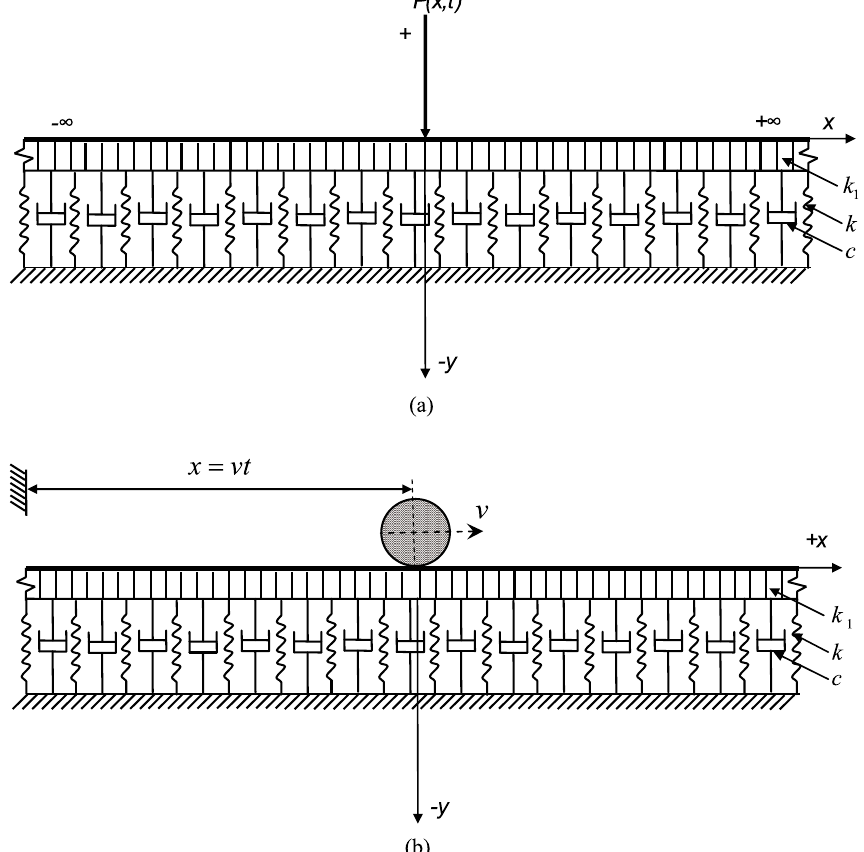
Fig. 1. Beam on Pasternak foundation subjected to a (a) moving load; and (b) moving